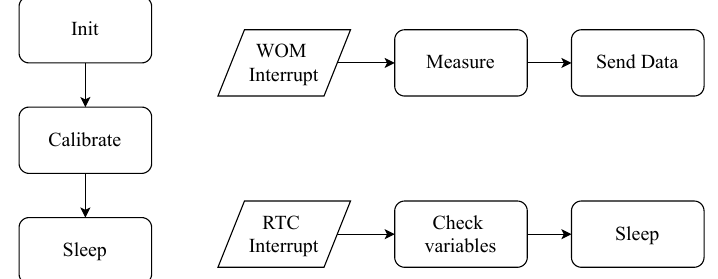
Figure 3. Flowchart code: The sensor node is calibrated once at initialization, a Wake On Motion (WOM) interrupt wakes up the system and measurements can start, an Real Time Counter (RTC) timer is used to periodically check the status of the sensor node to maximize autonomy.